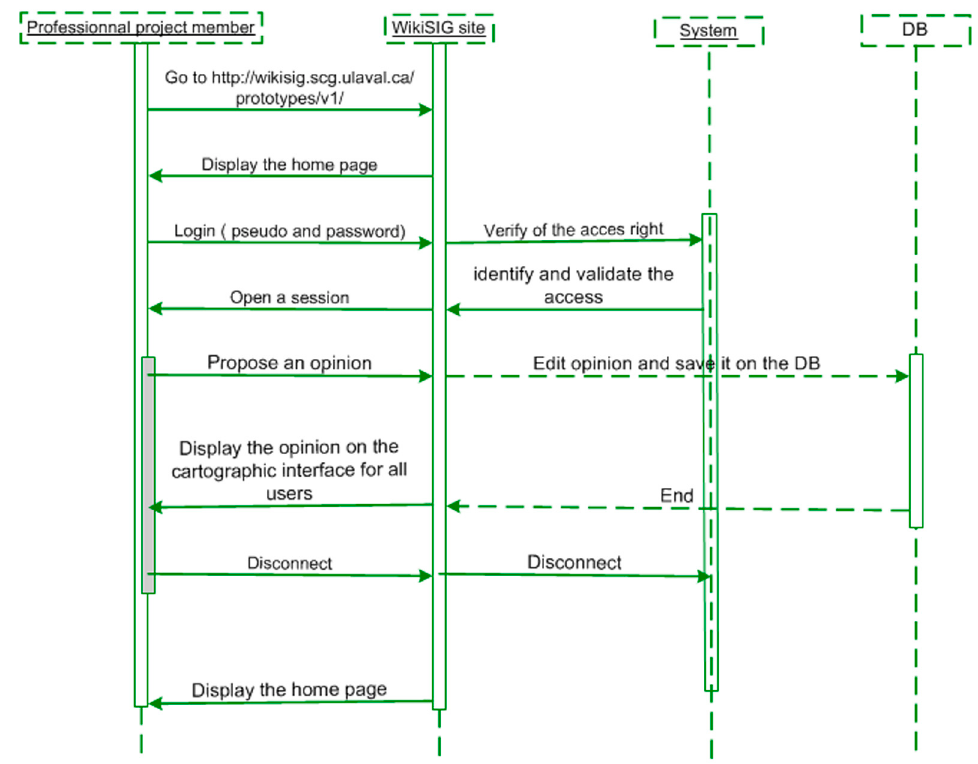
Figure 17. Sequence diagram of